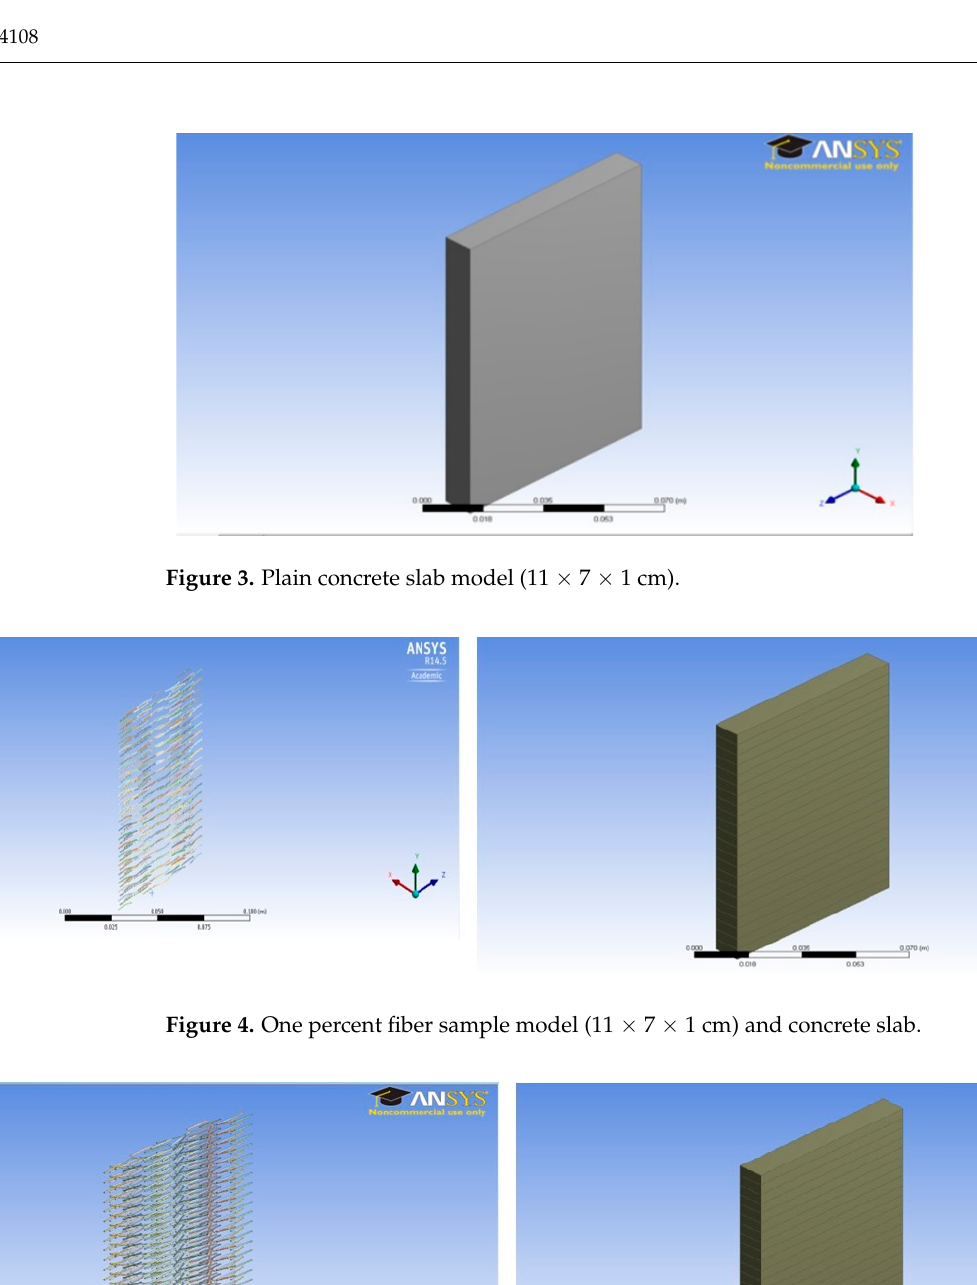
Figure 5. Two percent fiber sample model (11 × 7 × 1 cm) and concrete slab.